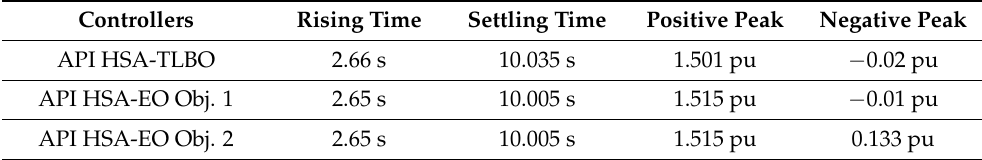
Table 8. Numerical comparison between the controllers at normal fourth case.